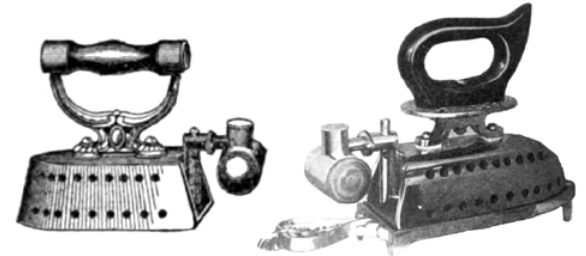
Figure 8. Alcohol-fueled flatirons, circa 1900. 67,68 Figure 9. Alcohol-fueled space heating stoves, circa 1900.